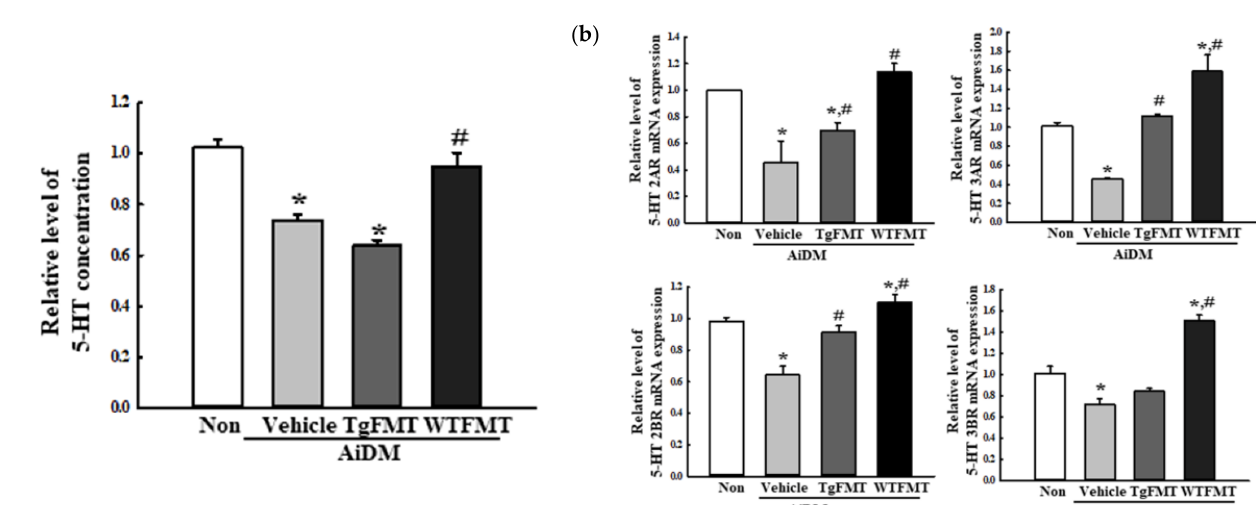
Figure 10. Levels of 5-HT and its receptor mRNA in AiDM+TgFMT mice. ( a ) Level of 5-HT for the excitatory function. The concentration of 5-HT was measured in the mid colon homogenate by an Enzyme-Linked Immunosorbent Assay. The detection range of this kit is 1.5–250 ng/mL of 5-HT. ( b ) Levels of 5-HT 2AR, 2BR, 3AR, and 3BR mRNA. The levels of the four transcripts in the total mRNA of the mid colons were measured by RT-qPCR analysis using the specific primers. The mRNA levels of the two genes were represented as the relative level of the intensity of β -actin. The tissue homogenate and total RNAs were prepared from three to five mice per group, and western blot, ELISA, and RT-qPCR analyses were performed in duplicate. The data are reported as the mean ± SD values. *, p < 0.05 compared to the Non-treated group. #, p < 0.05 compared with the AiDM+Vehicle treated group. Abbreviations: WT, wild-type; KO, knock out; FMT, fecal microbiota transplantation; KFMT, knockout mice FMT; WFMT, wild-type mice FMT; AiDM, antibiotics-induced depletion of microbiota; AiDM-WT, AiDM wild-type mice; AiDM-KO, AiDM knockout mice.